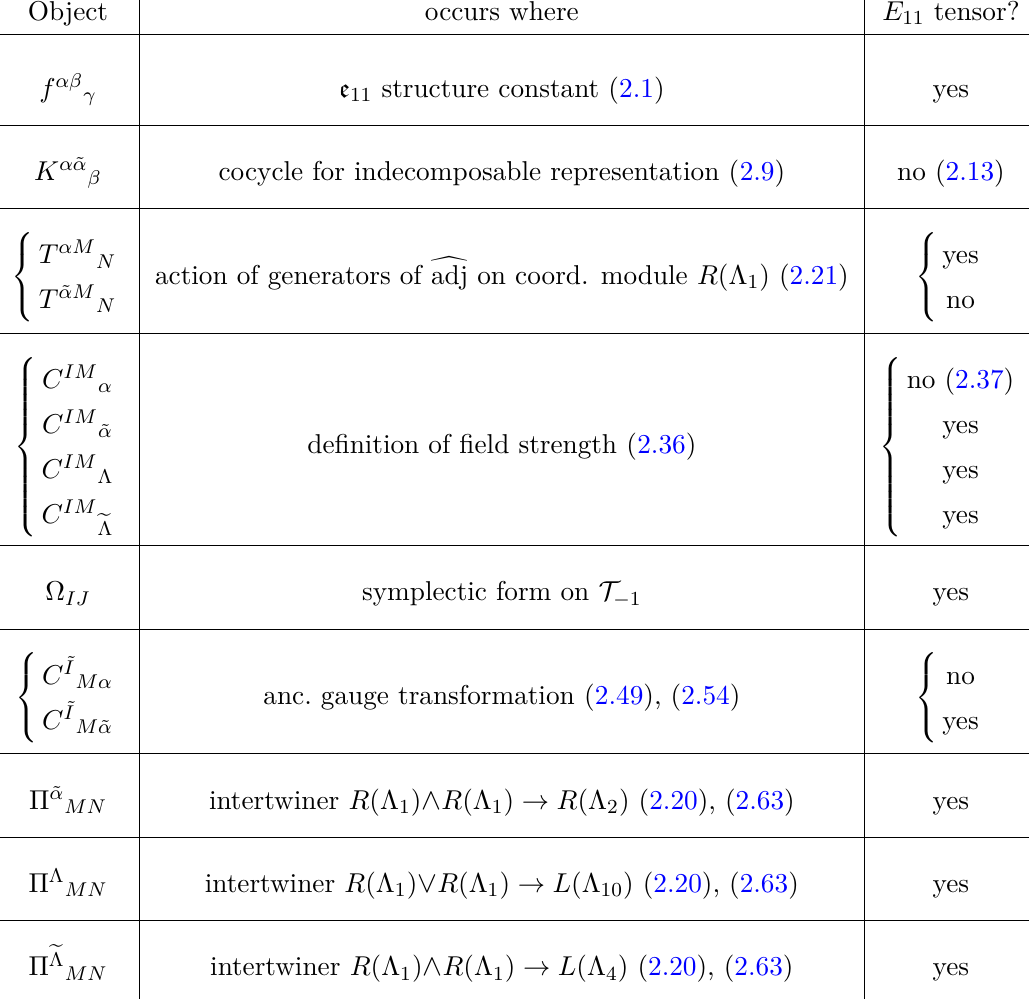
Table 2 . Summary of some E 11 objects that occur (up to conjugation) in the construction of E 11 exceptional field theory and whether they are covariant under rigid E 11 for the fully reducible